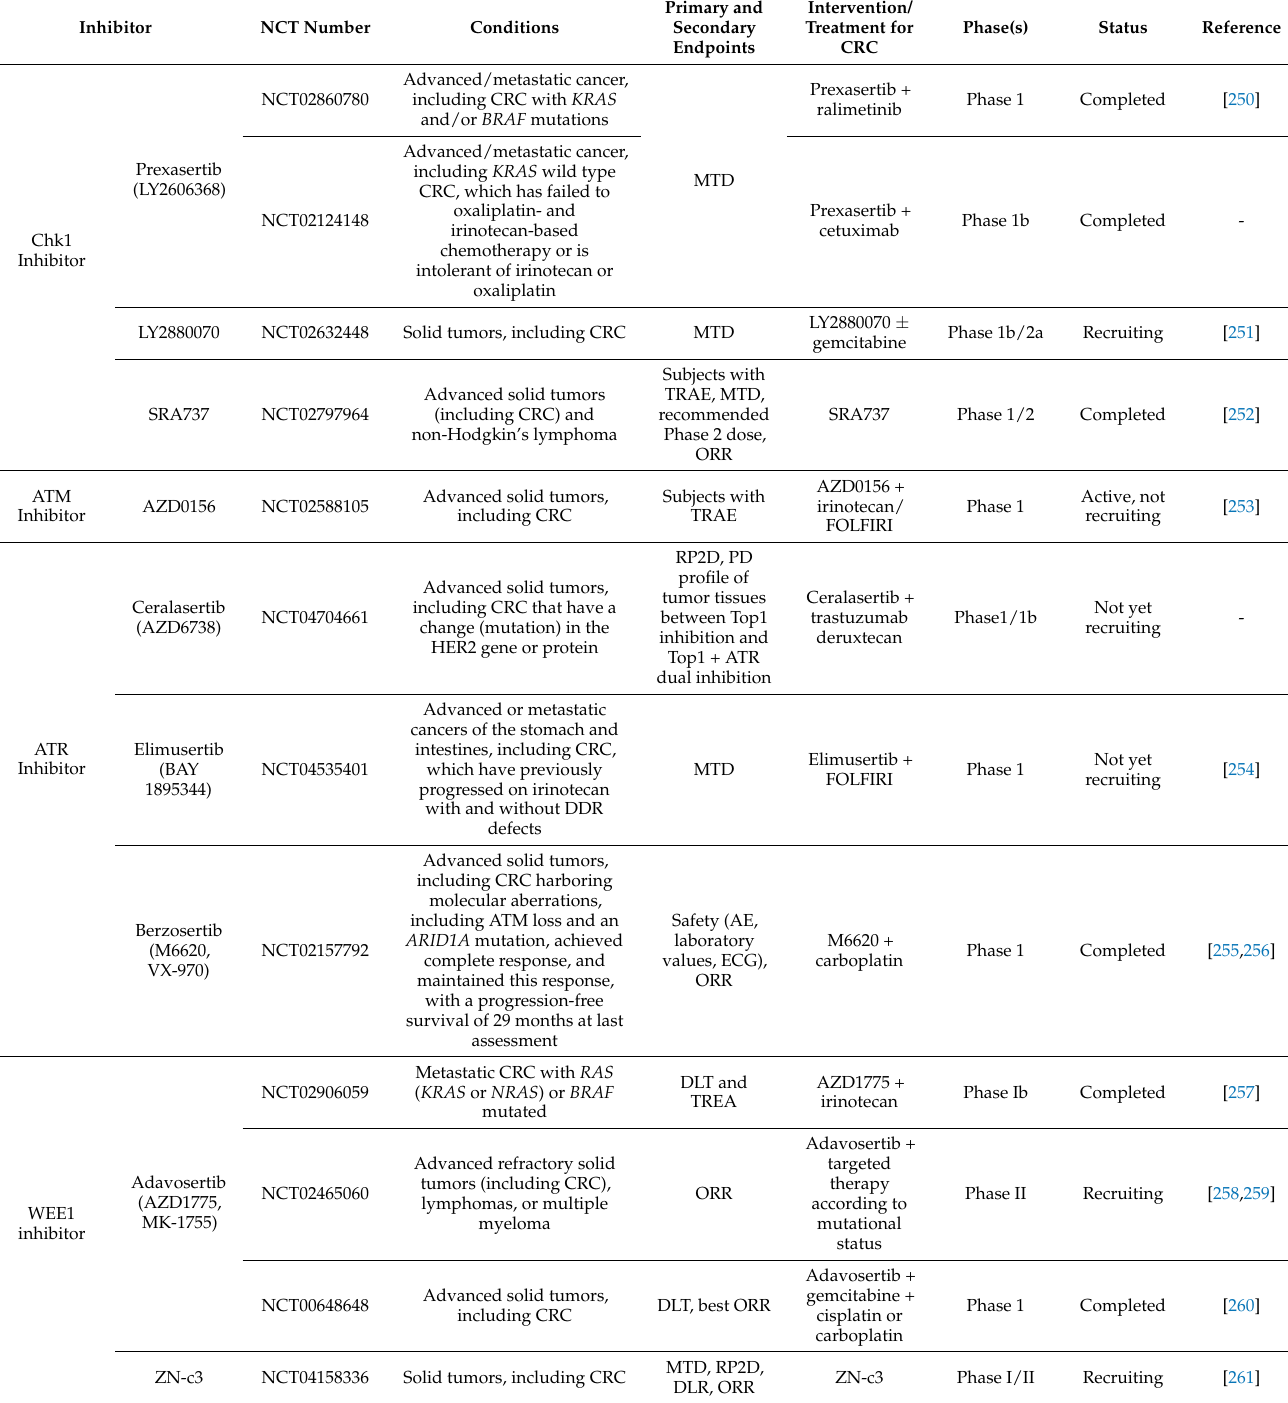
Table 2. Clinical Trials of DDR inhibitors in CRC